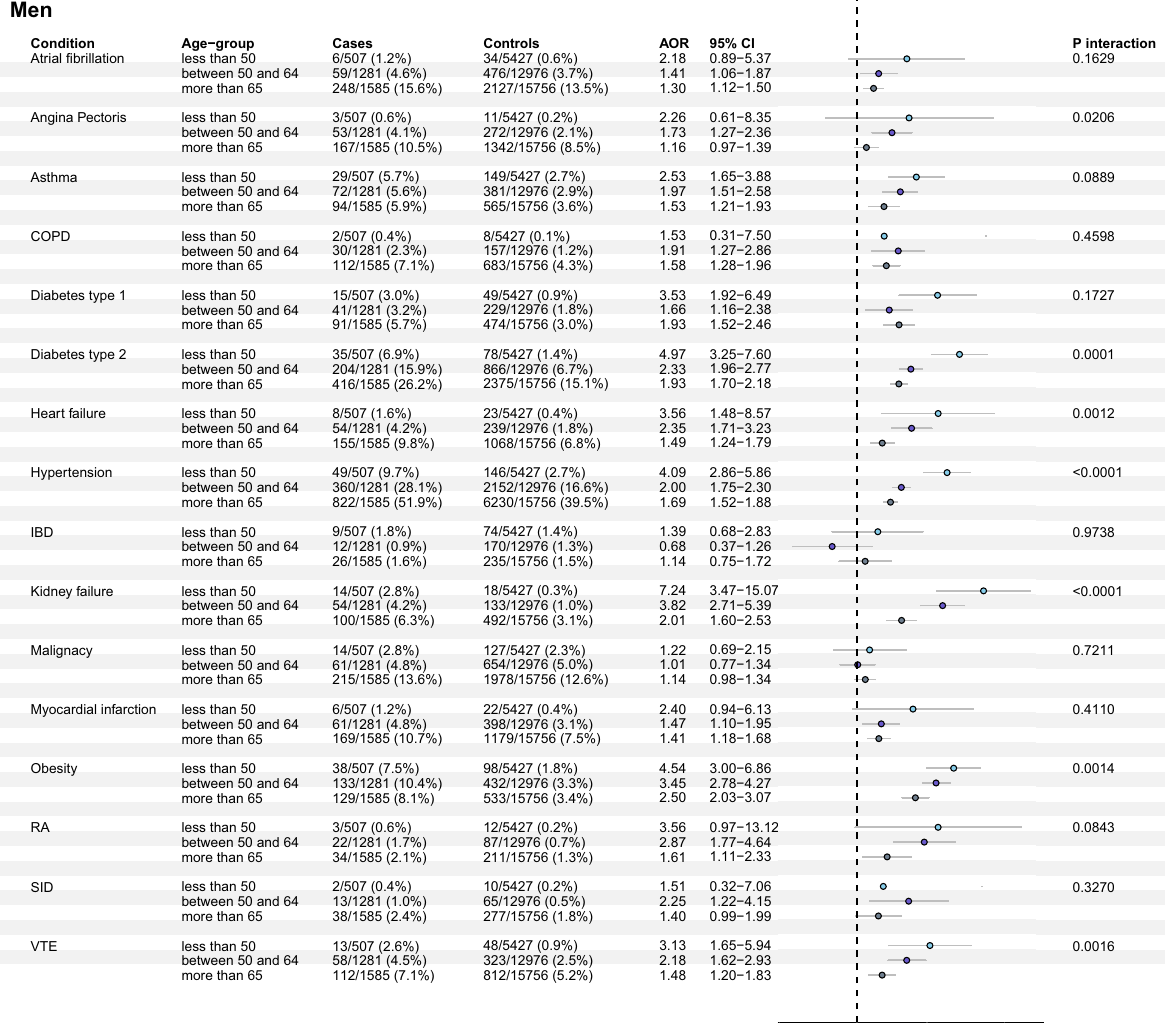
Fig. 3 Associations of pre-existing co-morbidities and severe COVID-19 (adjusted ORs with 95% CIs, and p-value for age interaction) in all three age groups of men. This fully adjusted model included co-variates of age, sociodemographic and socioeconomic variables (marital status, region of birth, disposable income, and educational level) for all exposures